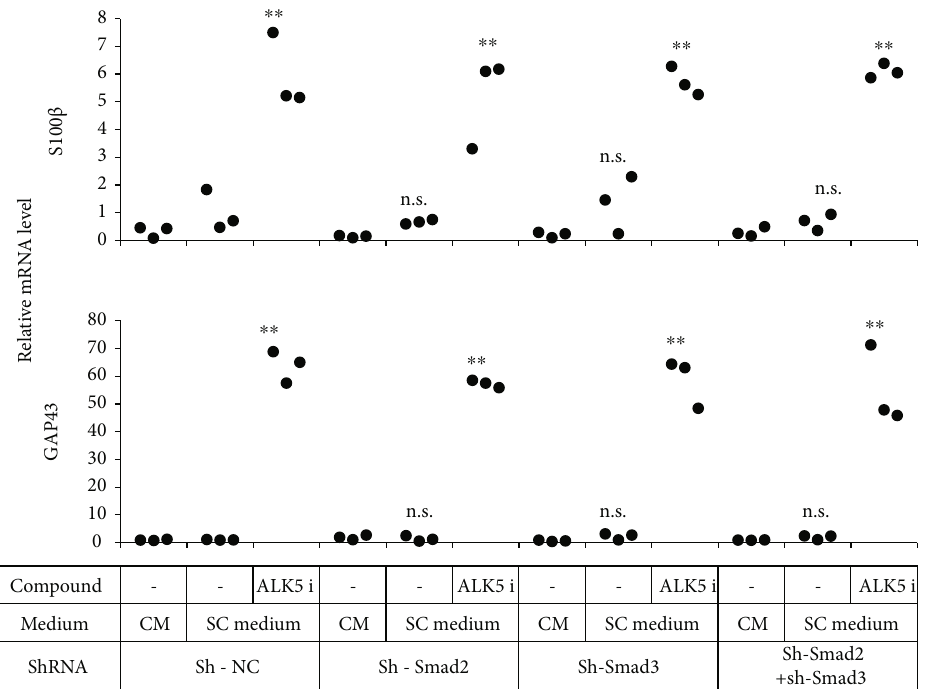
Figure 5: Neither Smad2 nor Smad3 were indispensable for induction of ADSCs into mSCLCs. ADSCs were transduced with lentiviral vectors encoding sh-NC, sh-Smad2, and/or sh-Smad3 as indicated. Forty-eight hours later, selection of transfected cells was started by adding puromycin and/or blasticidin. Stable transfectants were treated with BME and ATRA as indicated and cultured in the indicated culture medium as in Figure S1. After 14 days of culture, RNA was extracted from the cells and subjected to real-time RT-PCR to determine mRNA levels of the indicated genes. Each dot represents a triplicate value. ∗∗ p < 0 : 01 vs. sh-NC. n.s.: no signi fi cant di ff erence between the indicated